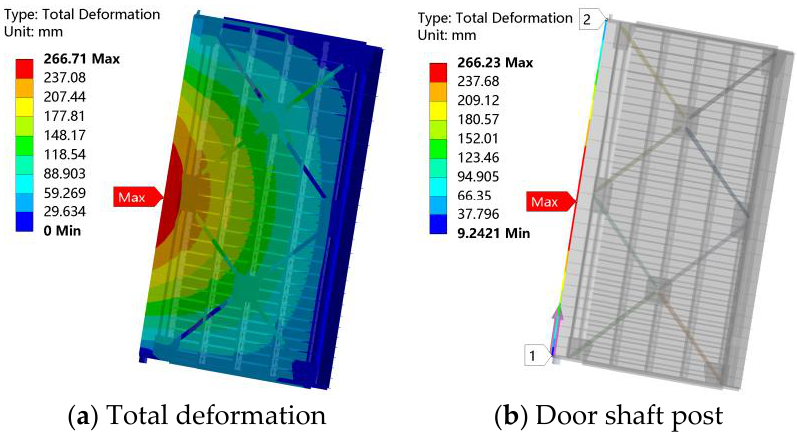
Figure 13. ( a ) Deformation of the gate body, ( b ) Deformation of the shaft column of the gate with a back tie rod in a static state.